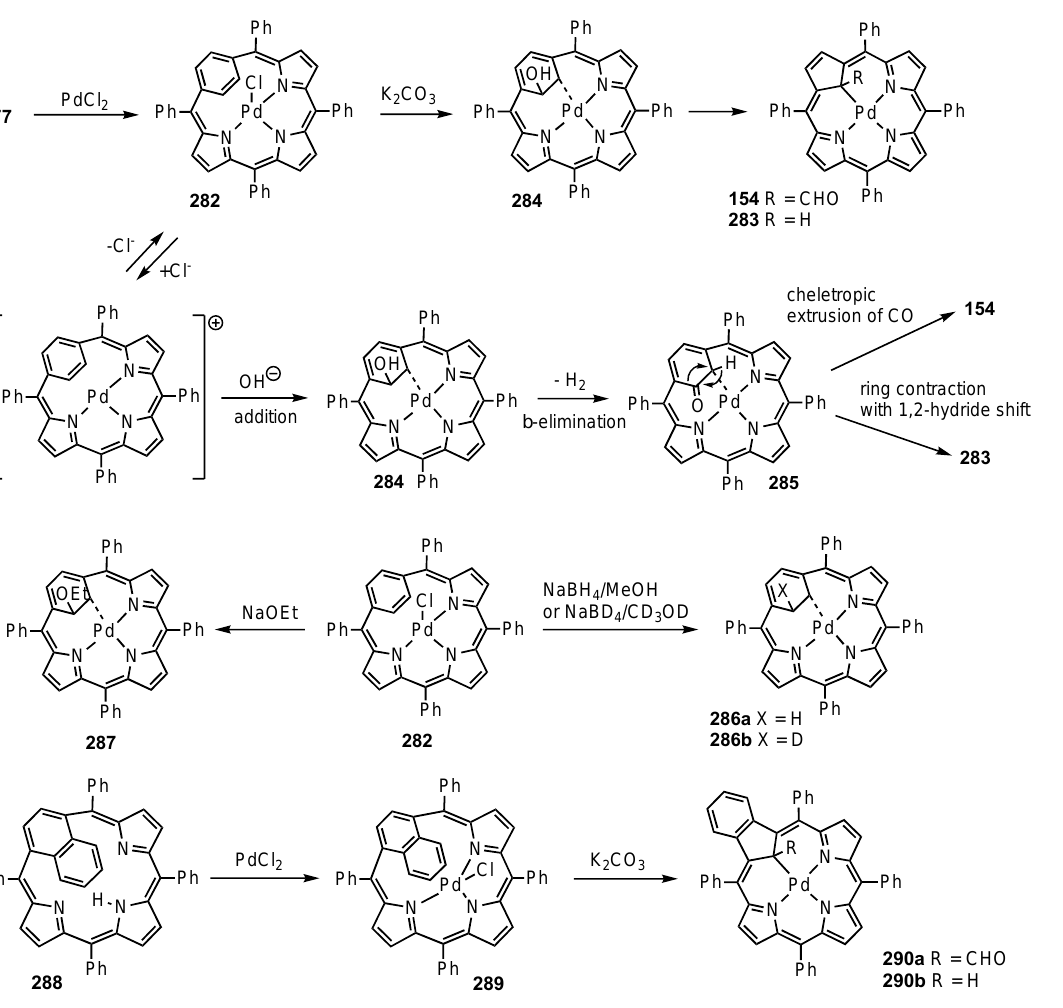
Scheme 46. Palladium-mediated ring contractions of p -benziporphyrin and 1,4-naphthiporphyrin. Reaction of 277 or 288 with sodium tetrachloroaurate also induced ring contractions Reaction of 277 or 288 with sodium tetrachloroaurate also induced ring